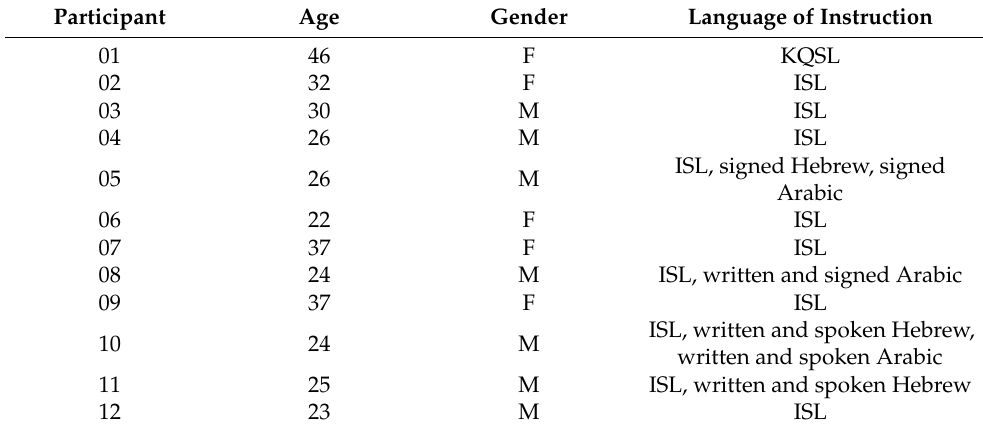
Table 4. Participant